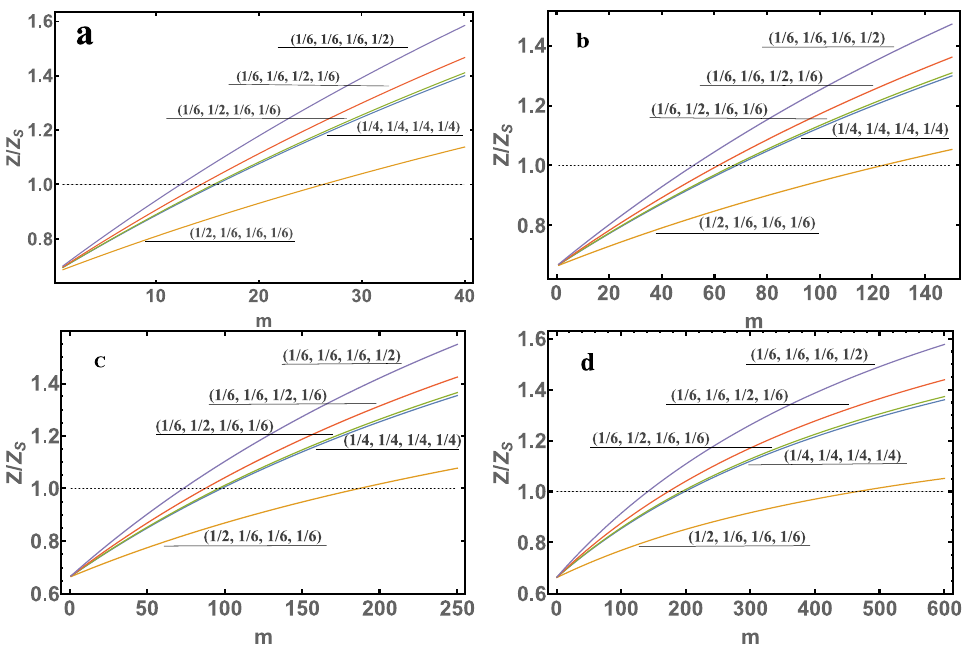
Figure 5. The dependence of Z / Z S for five cases (see Table 1) of the carriage of cargo of m mass to the destinations is presented. The values in parentheses correspond to the values in Table 1, for example, ( 1/6,1/6,1/6,1/2 ) correspond to case 5 in this table. This means that 1/6 of the total cargo carried by the vessel is unloaded at each of the discharge points of at each of the discharge points (Sjojaha, Tambey and Antipayuta), and 1/2 is unloaded at Yamburg. ( a ) calculation for F = 0 USD/h, ( b ) calculation for F = 3300 USD/h; ( c ) calculation for F = 6600 USD/h; ( d ) calculation for F (cid:29) 1000